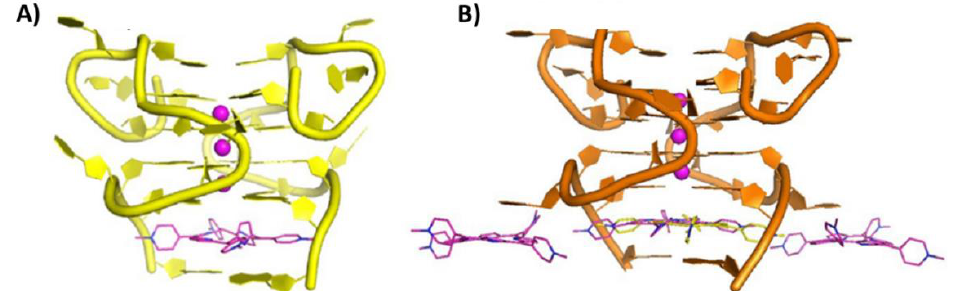
Figure 15. Crystal structure of the complex between the bimolecular parallel G-quadruplex IE180 of sequence r(GGCUCGGCGGCGGA) and TMPyP4 at ( A ) 1:1 or ( B ) 1:2 G-quadruplex/ligand stoichiometry. 5′ - and 3′ -ends of the G-quadruplex are at the top and bottom, respectively. Adapted with permission from ref. [98], Copyright 2020 Oxford University Press.